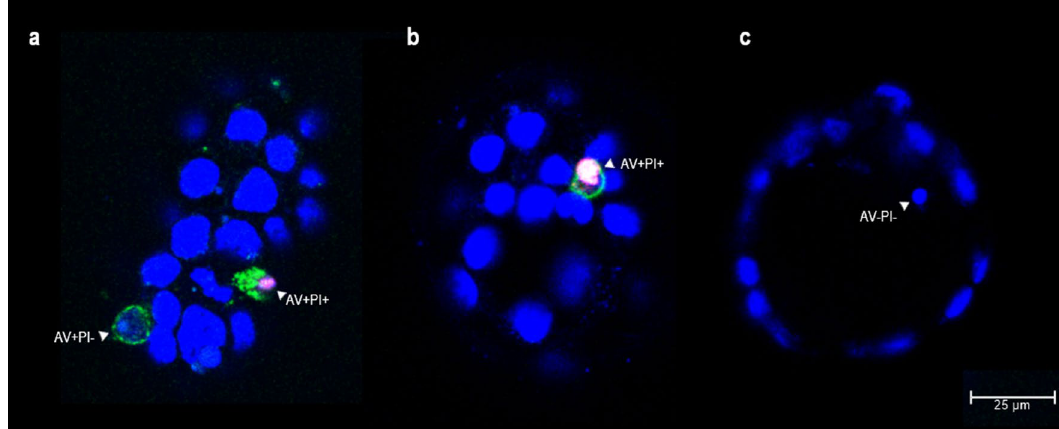
Figure 1. Analysis of phosphatidylserine externalization in mouse blastocysts. Images were obtained by confocal laser scanning microscopy (magnification × 400). Single optical sections of three blastocysts are shown in pictures a-c. Annexin V staining was performed to determine the presence of phosphatidylserine on the outer surface of the plasma membrane (AV + = green); propidium iodide staining of DNA to determine cell membrane integrity (PI + = red); and Hoechst 33342 DNA staining to visualize nuclear morphology (blue). ( a ) apoptotic AV + PI- cell showing chromatin fragmentation; secondary necrotic AV + PI + cell showing chromatin condensation; ( b ) secondary necrotic AV + PI + cell showing chromatin condensation; ( c ) apoptotic AV-PI- cell showing chromatin